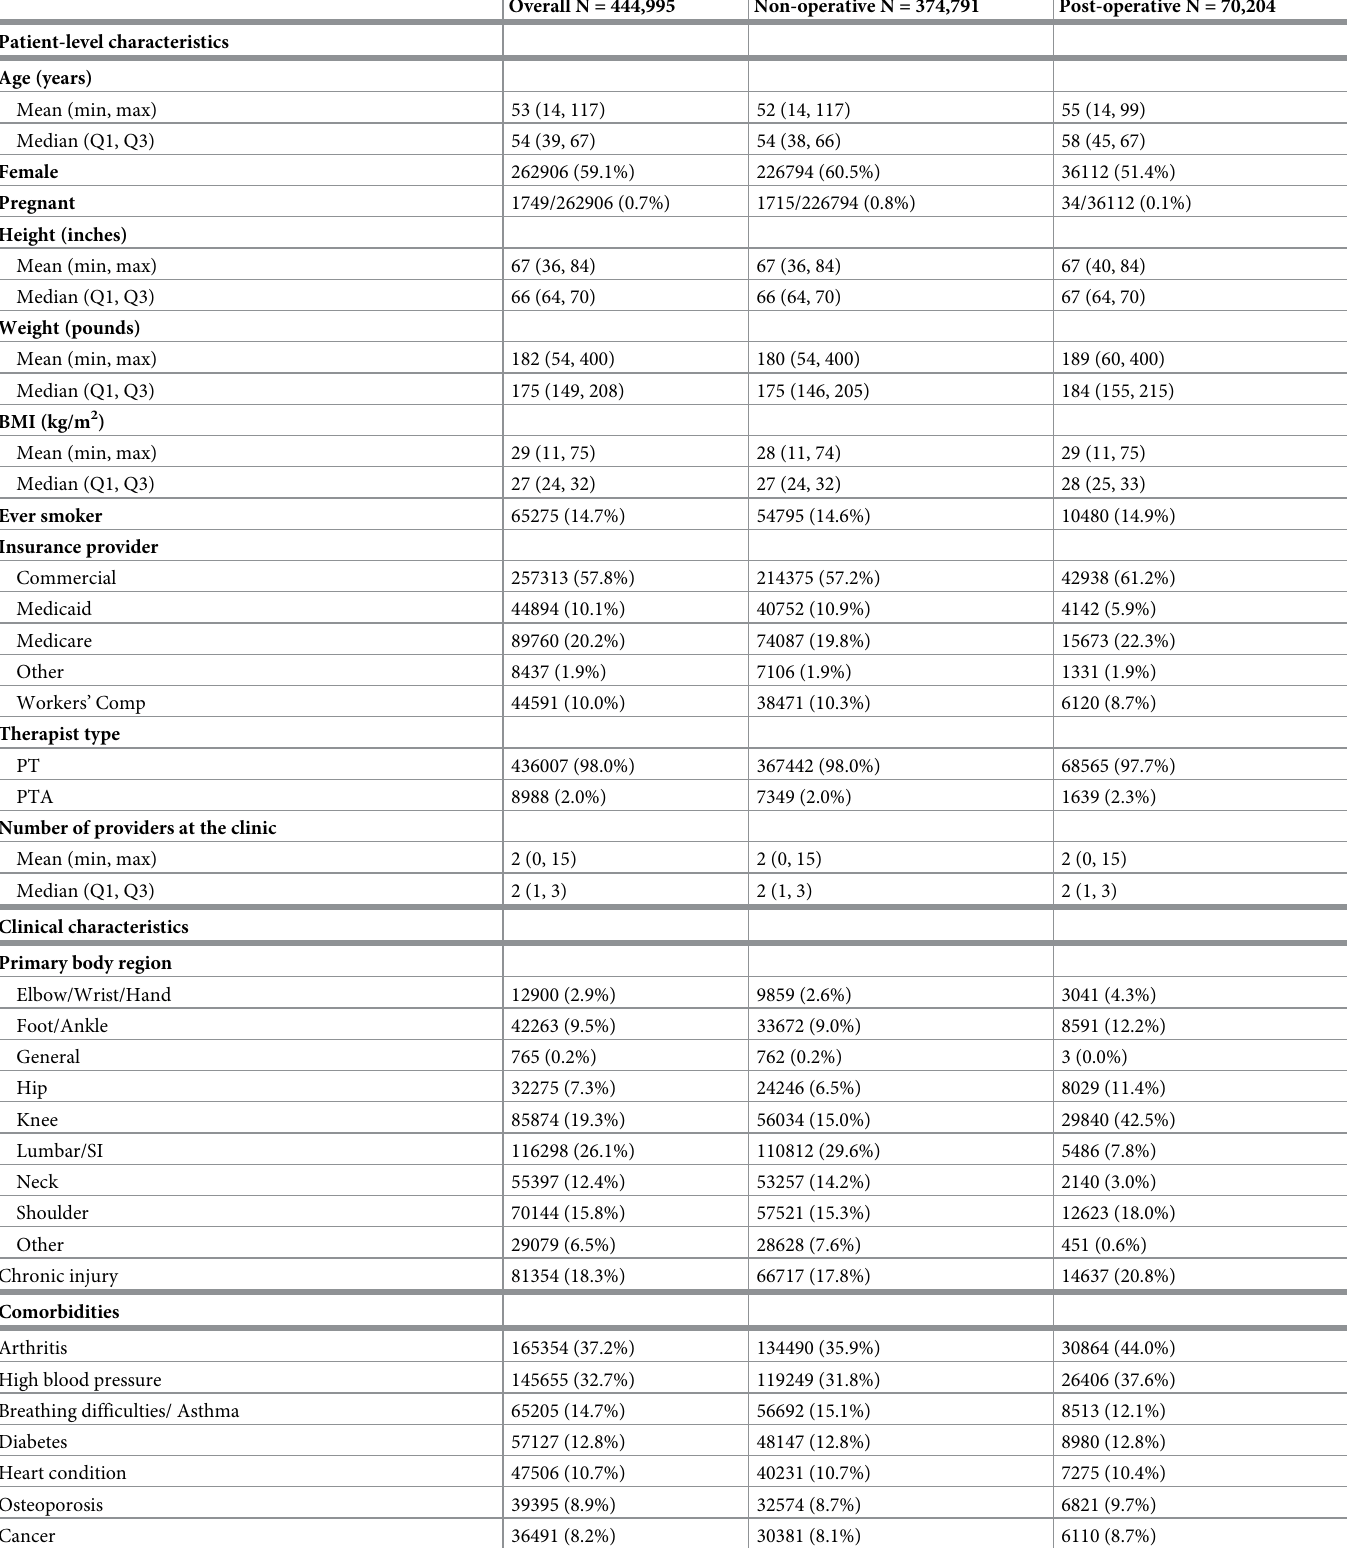
Table 1. Characteristics of the study population at initial